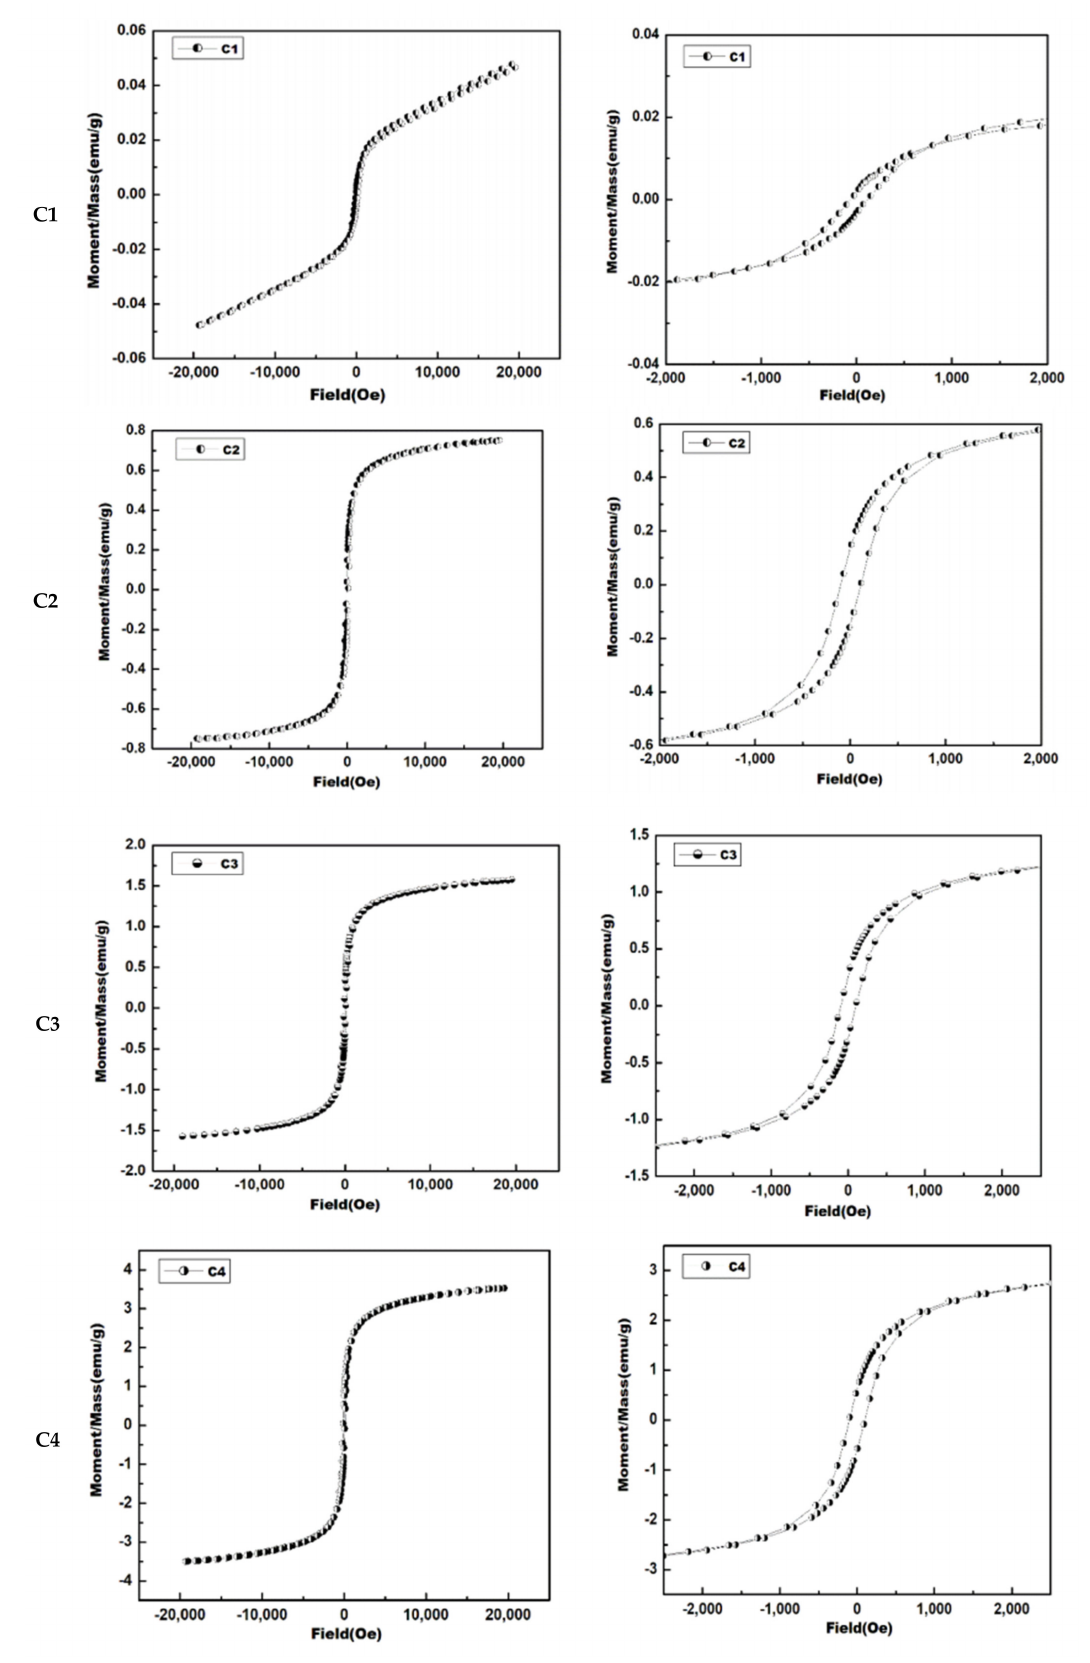
Figure 9. M-H curves at room temperature for C1 , C2 , C3 , and C4